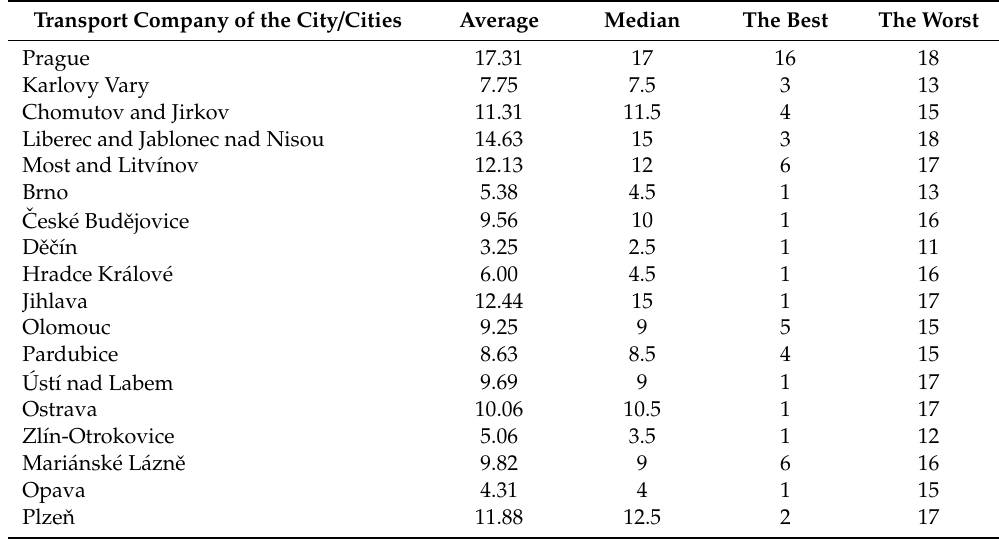
Table 3. Ranking of transport companies within entire monitored period (variant I.). Transport Company of the City / Cities Average Median The Best The Worst Prague 17.31 Karlovy Vary Chomutov and